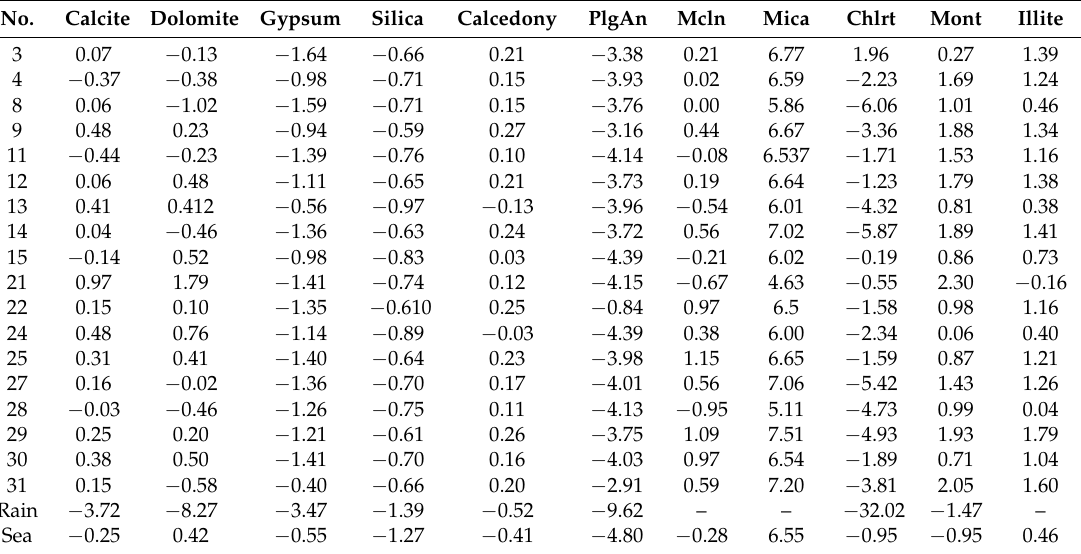
Table 2. Mineral Saturation indices for phases in NETPATH geochemical models. Positive values indicate over saturation; negative values indicate under